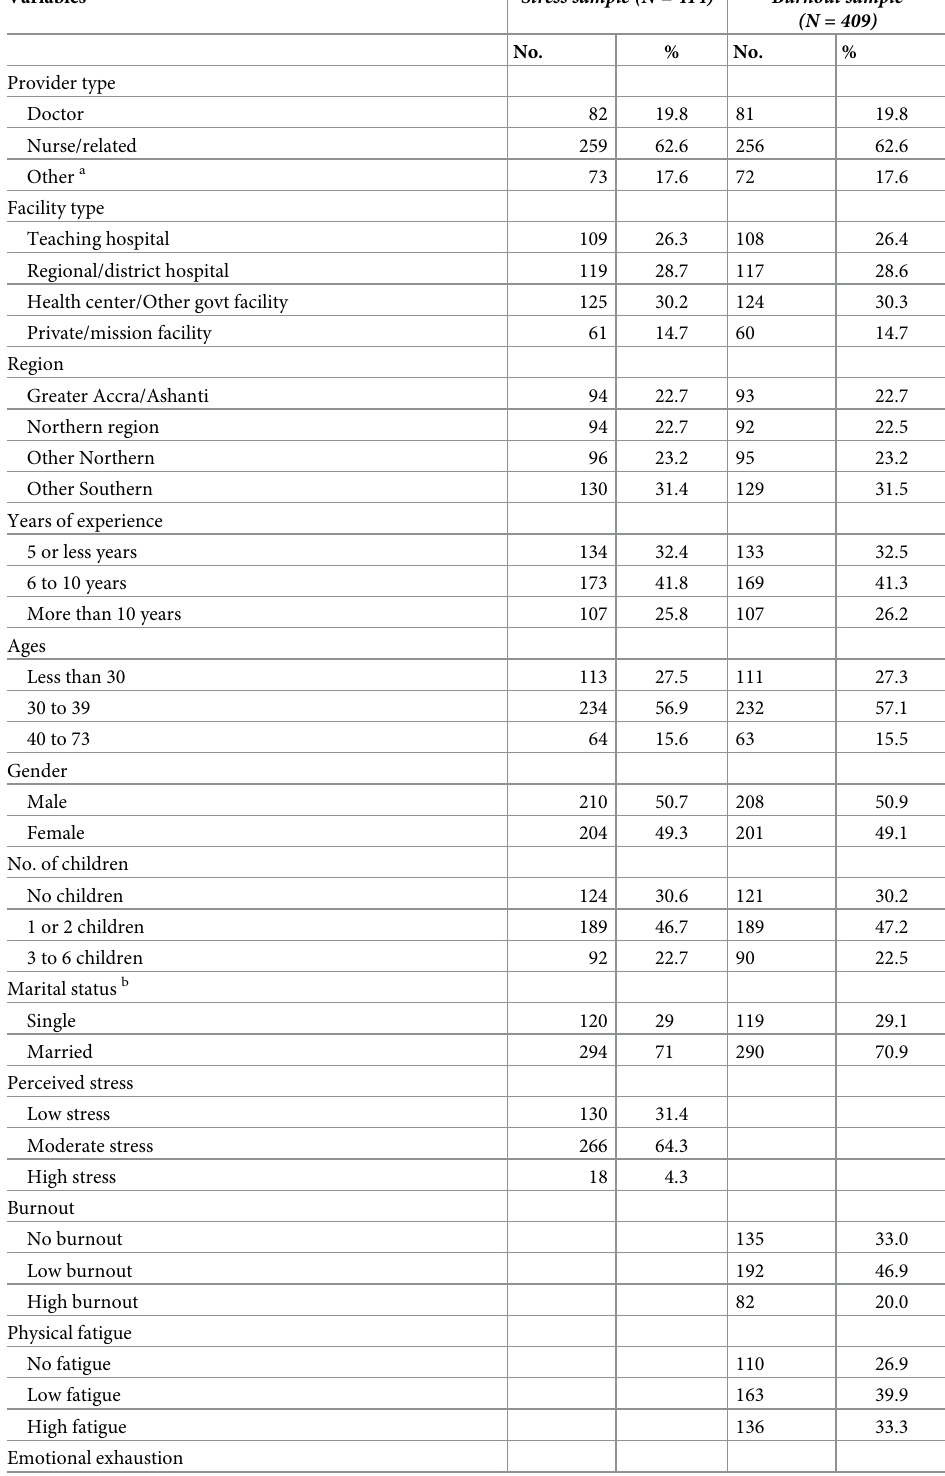
Table 1. Participant demographics and univariate distribution of study variables, healthcare workers in